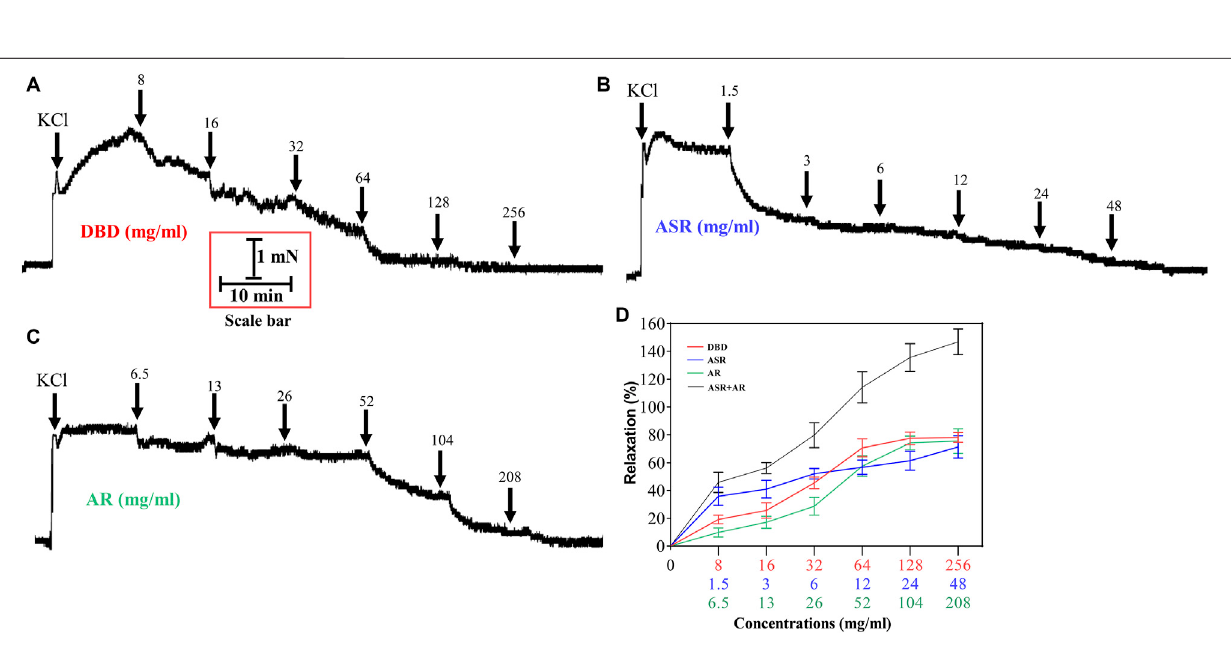
Frontiers in Pharmacology |